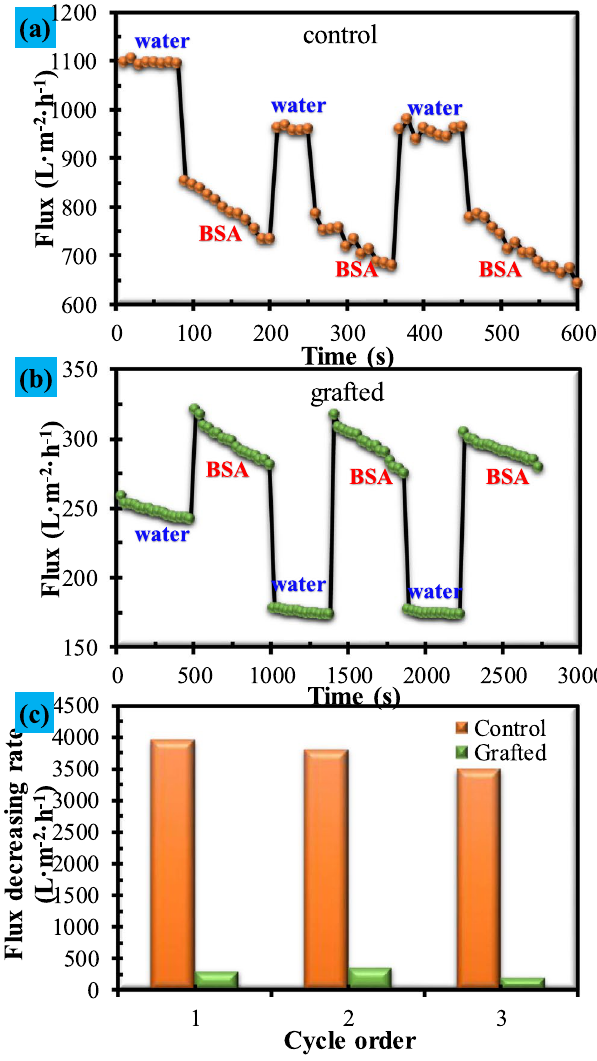
Figure 10. Antifouling performance of the control and grafted membranes: ( a ) flux of the control membrane by alternate filtration of pure water and BSA solution; ( b ) flux of the grafted membrane by alternate filtration of pure water and BSA solution; ( c ) flux decreasing rate of the control and grafted